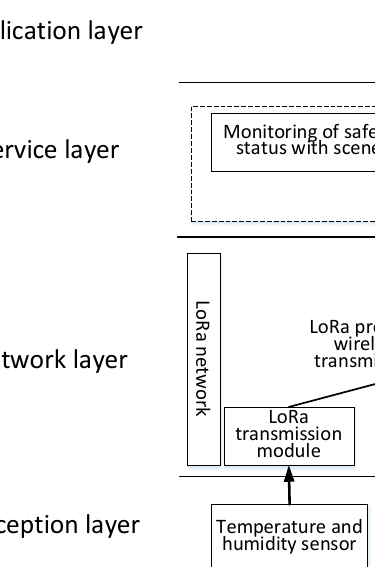
Figure 6. Sensing terminals.